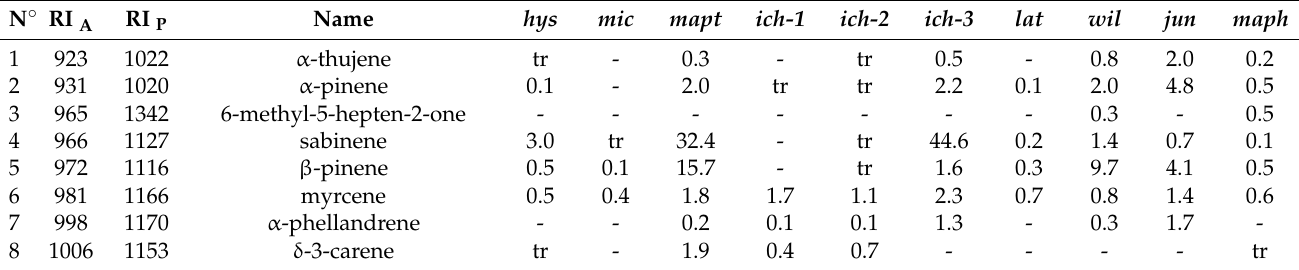
Table 2. Chemical composition of leaf essential oil of ten Papeda oil